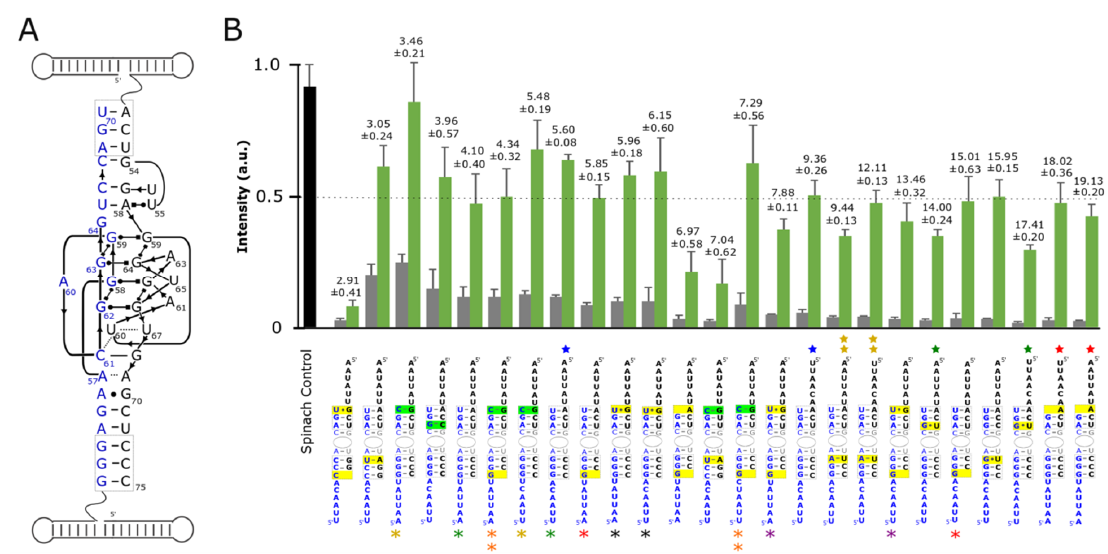
Figure 2. Optimization of split-Spinach as reporter for RNA nanoring assembly. ( A ) 2D diagram of split-Spinach aptamer core (adapted from Ouellet Front. Chem. 2016) [16] ( B ) Fluorescent data of variant split-Spinach sequences tested normalized to unimolecular Spinach control (black bar). Green bars indicate fluorescence associated with the fully-assembled nanoring while grey bars represent fluorescence associated with the incubation of the alpha and delta strands containing the split aptamer alone. Variants are ranked according to their respective sensitivities (i.e. ratio of fluorescence in ring/fluorescence of dimer shown above the green and grey bars). Split-Spinach variants that differ from each other in the linker sequences are identified by colored asterisks (alpha strand) or stars (delta strand). Pairs that differ by only a single linker are identified by the same color. The number of asterisks or stars indicate the identity of the particular linker strand used. Data is based on a minimum of three trials. The error bars represent the standard deviation associated with each collection of measurements.